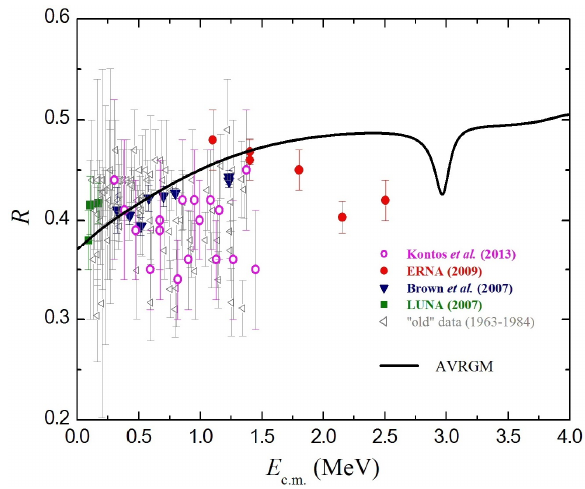
Fig. 2. Energy dependence of the 3 He( α , γ ) 7 Be branching ratio .